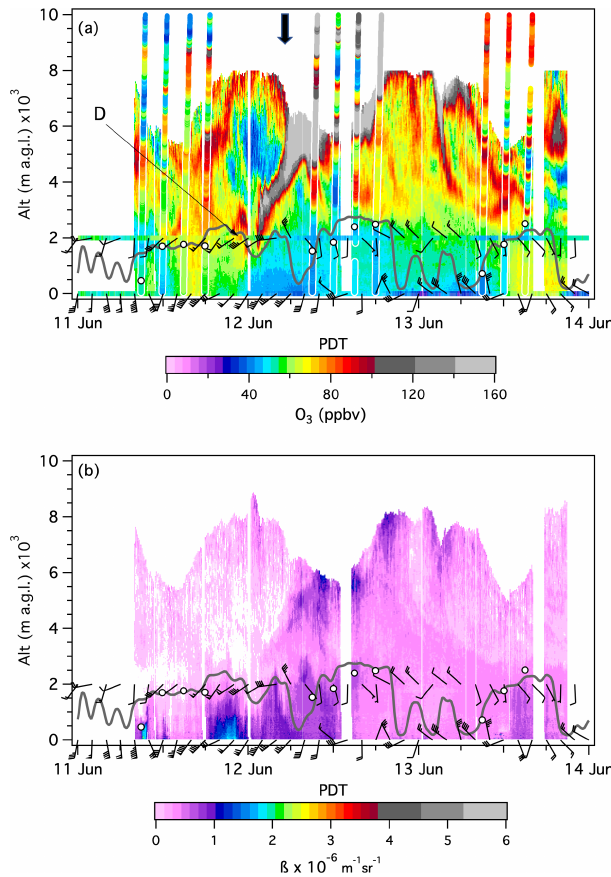
Figure 14. Same as Fig. 11, but for IOP4. The heavy black arrow corresponds to the 00:00UT 29 June 300hPa plot in Fig.